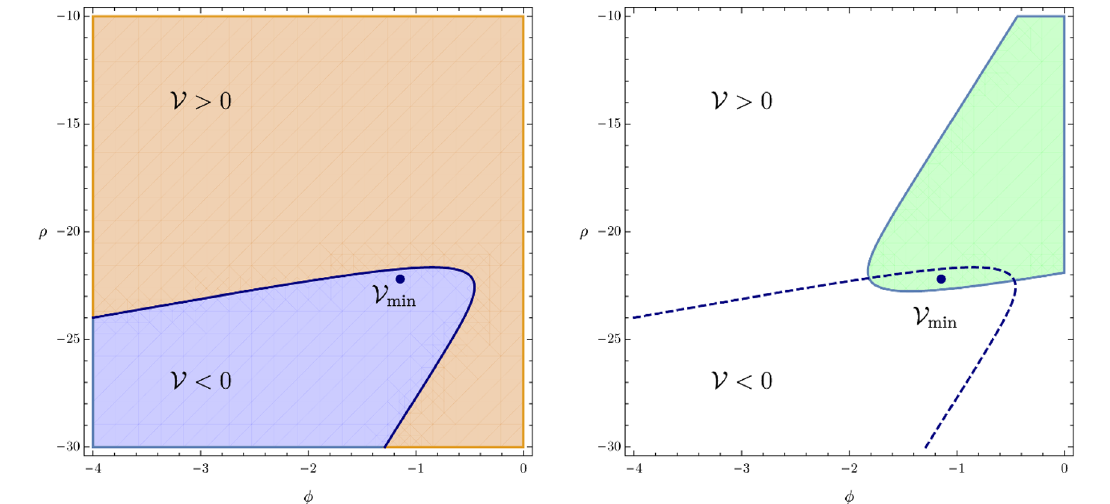
Figure 1 . Plots of the regions where the potential in eq. (5.11) is positive and negative de(cid:12)nite (left) and the region of stability, where the Hessian is positive de(cid:12)nite (right), for the BSB and type 0 0 B orientifold models. We have chosen n = 10 6 and V is expressed in units of T